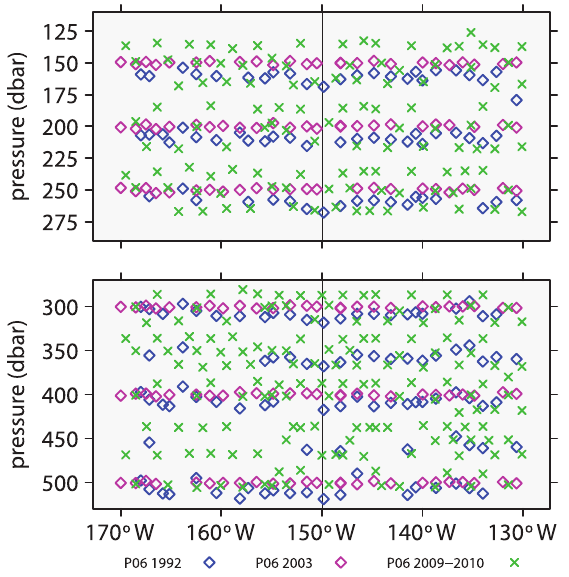
Figure 3. Locations of data from P16 surveys. The vertical lines indicates where P06 and P16 cross. Blue indicates data from 1991; magenta, 2005.